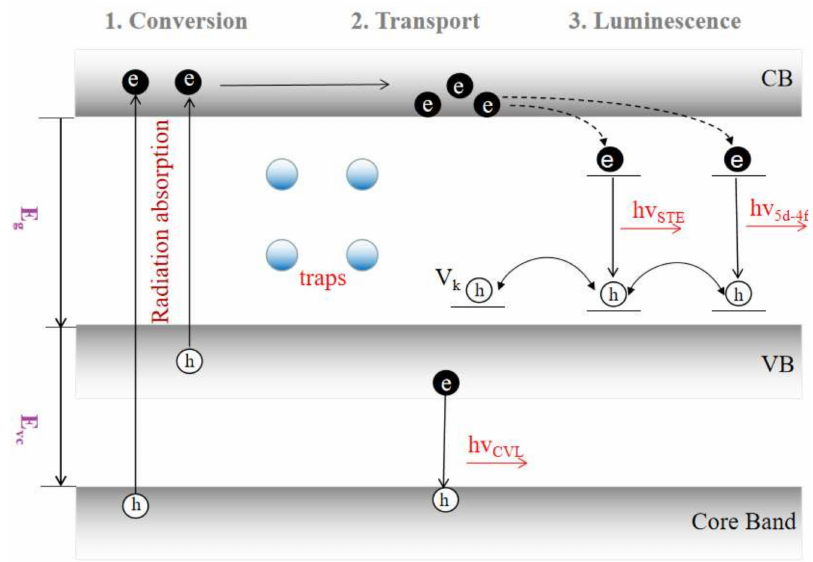
Figure 1. Schematic representation of scintillation mechanism. CB: Conduction band, VB: Valence band, E g : Energy band gap, E vc : Energy difference between the top of the valence band and the outermost-core state, V k : Self-trapped hole, v STE : Photon frequency of self-trapped excitonic lumines- cence photons, v 5d-4f : Photon frequency of Ce 5d–4f transition, v CVL : Photon frequency of core to valence luminescence, h: Planck’s